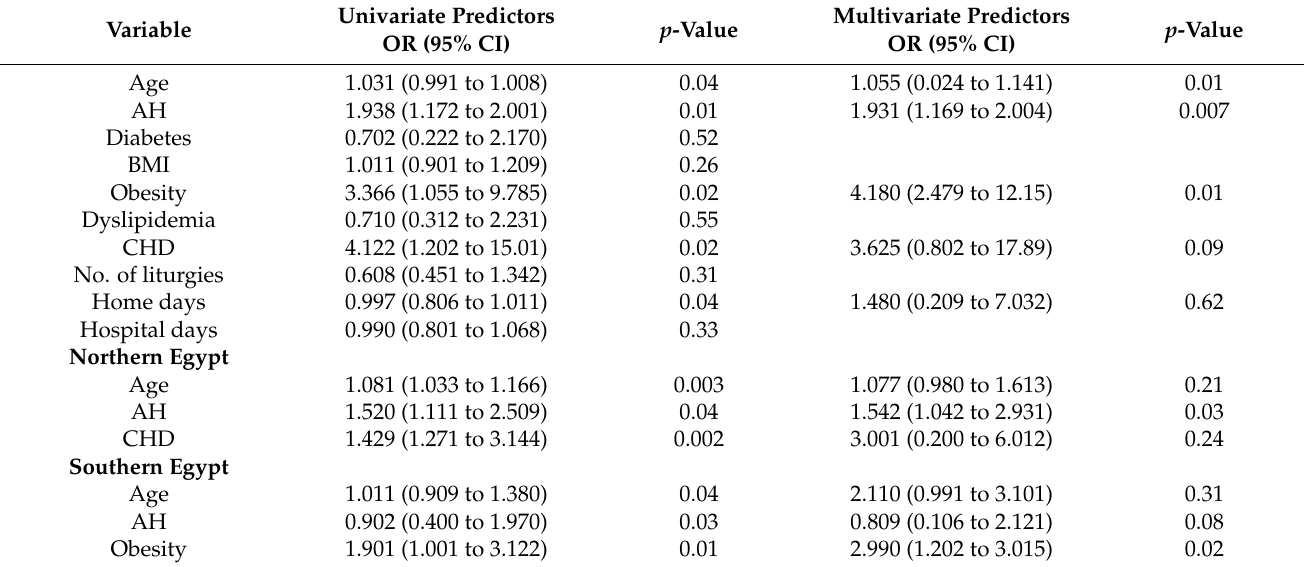
Table 5. Predictors of MAE among infected